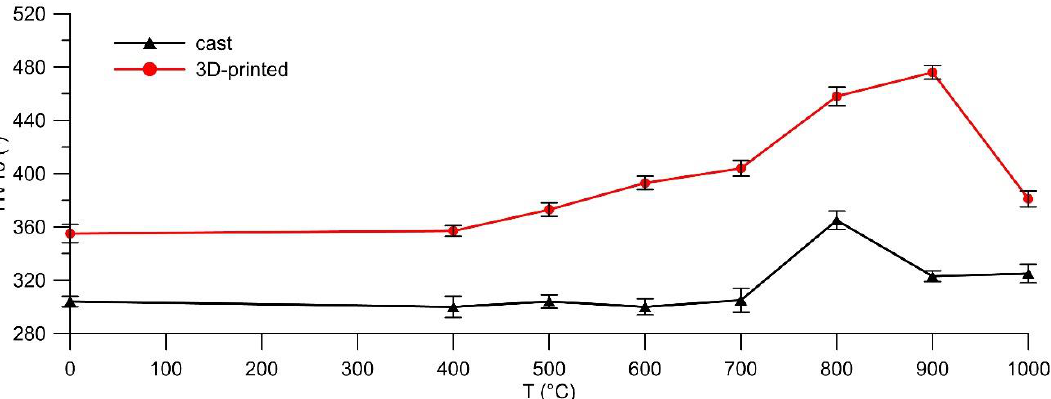
Figure 7. Hardness changes with increasing temperature.